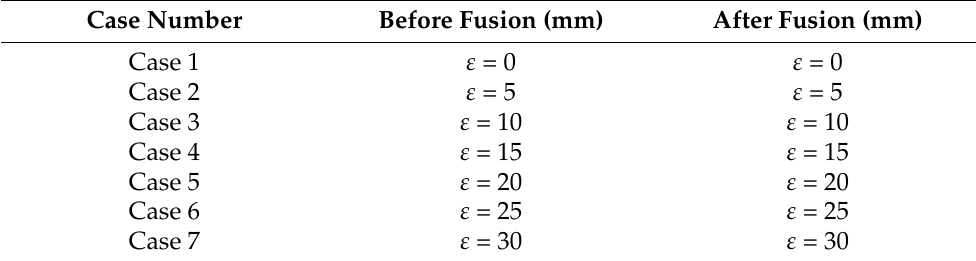
Table 7. Performance warning cases of bridge at the